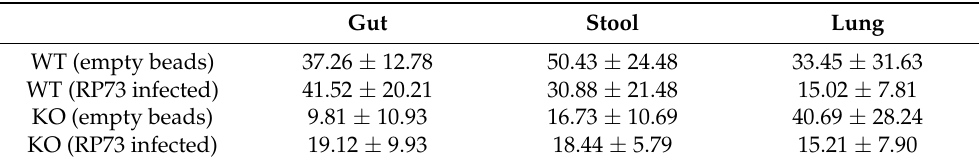
Table 1. Alpha diversity of mice microbiota. WT and KO mice not infected (empty beads) and infected with P. aeruginosa (RP73) are shown (WT mice: empty beads n = 8 and RP73 infected n = 17; KO mice: empty beads n = 7 and RP73 infected n = 13). Values (means ± standard deviation) of the Inverse Simpson index are reported.